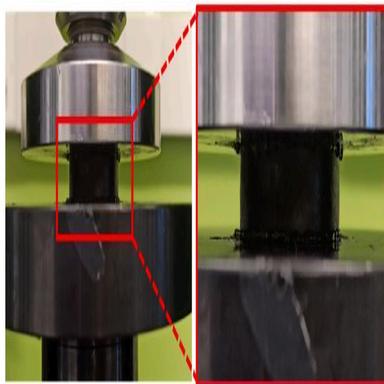
Compression NRB50 sample without bulging at 35% compressive strain.